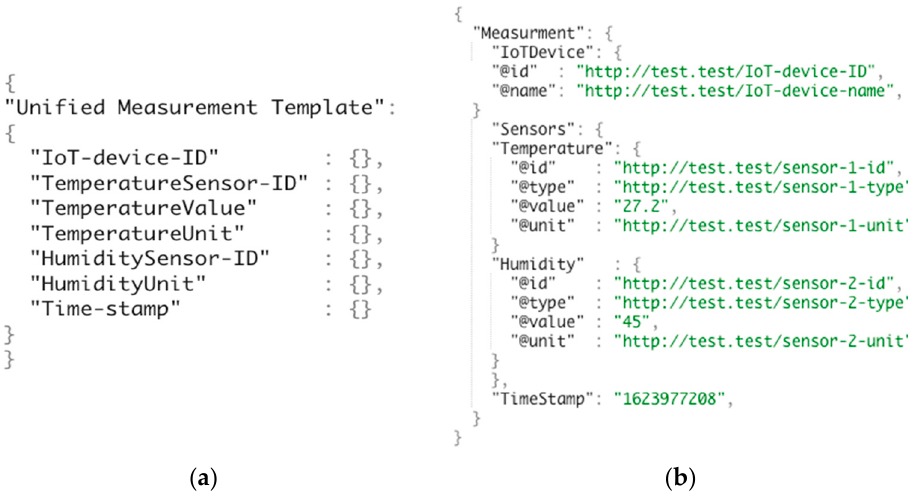
Figure 3. ( a ) Unified measurement template in IoT device metadata; ( b ) measurement of thermometer with two sensors example.